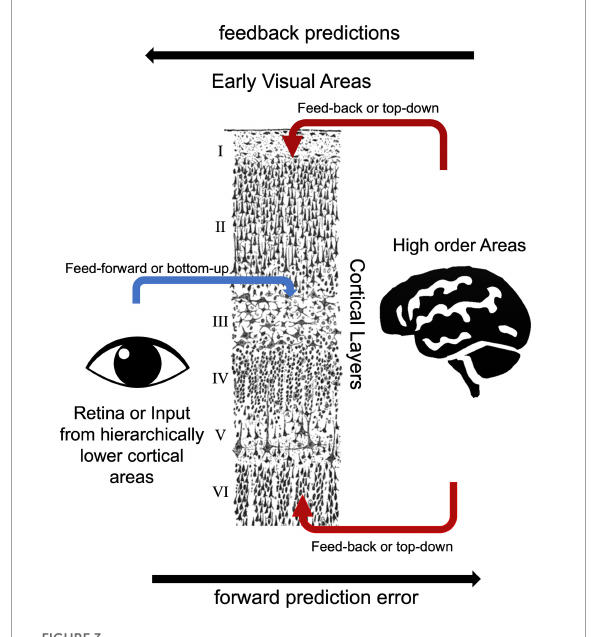
FIGURE3 Bottom-up and top-down visual processing pathways to the early visual areas. The drawing of cortical layers is adapted from y Cajal (1899).